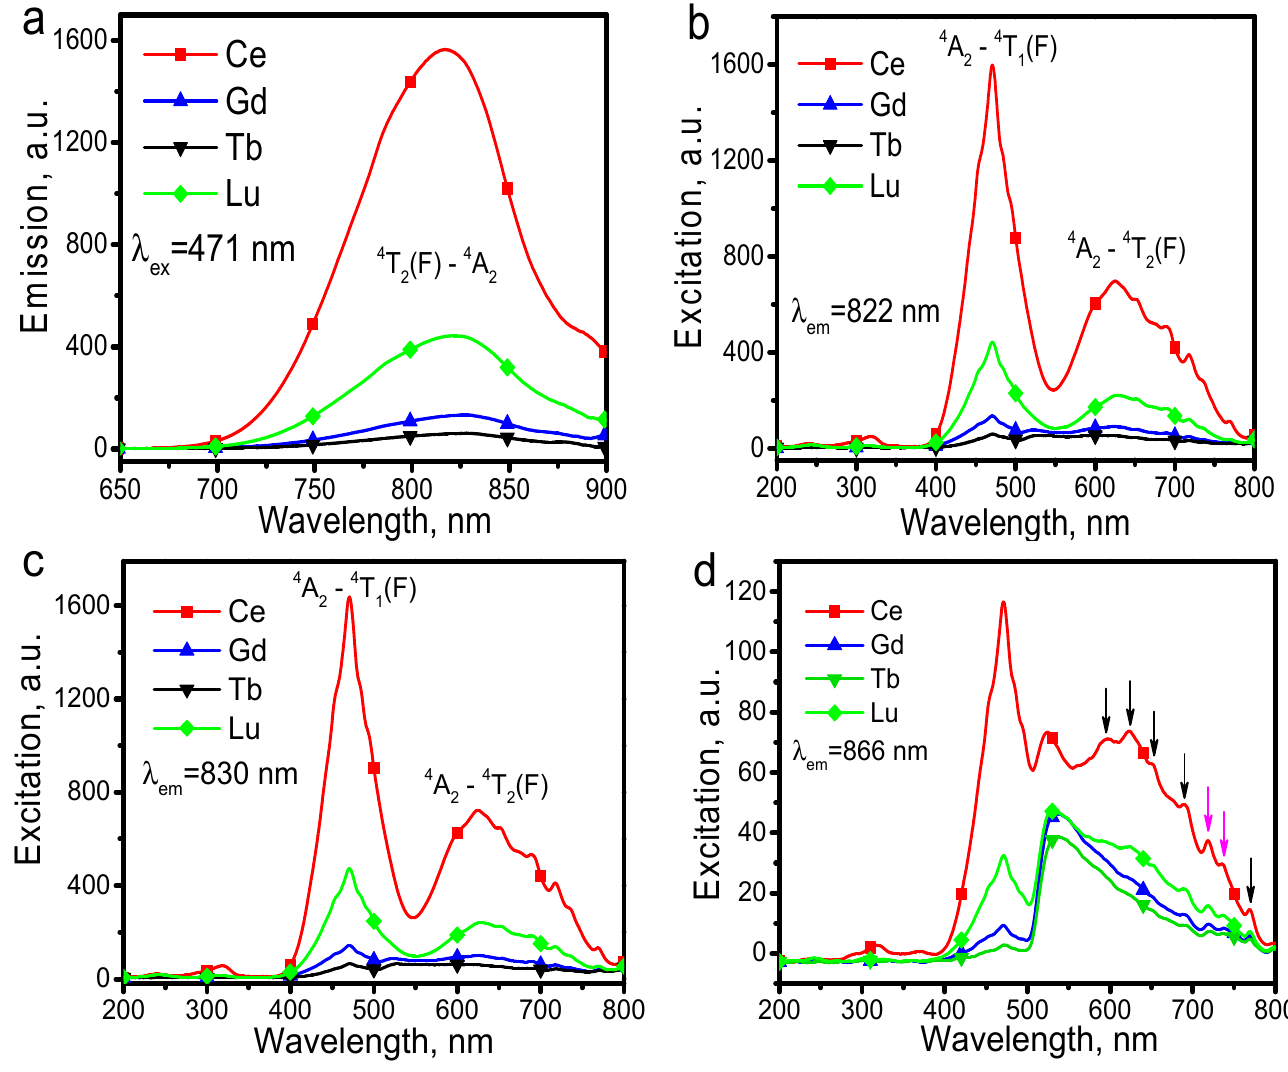
Figure 3. Emission and excitation spectra of RESc 3 (BO 3 ) 4 :Cr 3+ (RE = Ce, Gd, Tb, Lu). ( a ) The emission spectra under 471 nm excitation, ( b – d ) the excitation spectra by monitoring 822, 830, and 866 nm, respectively.